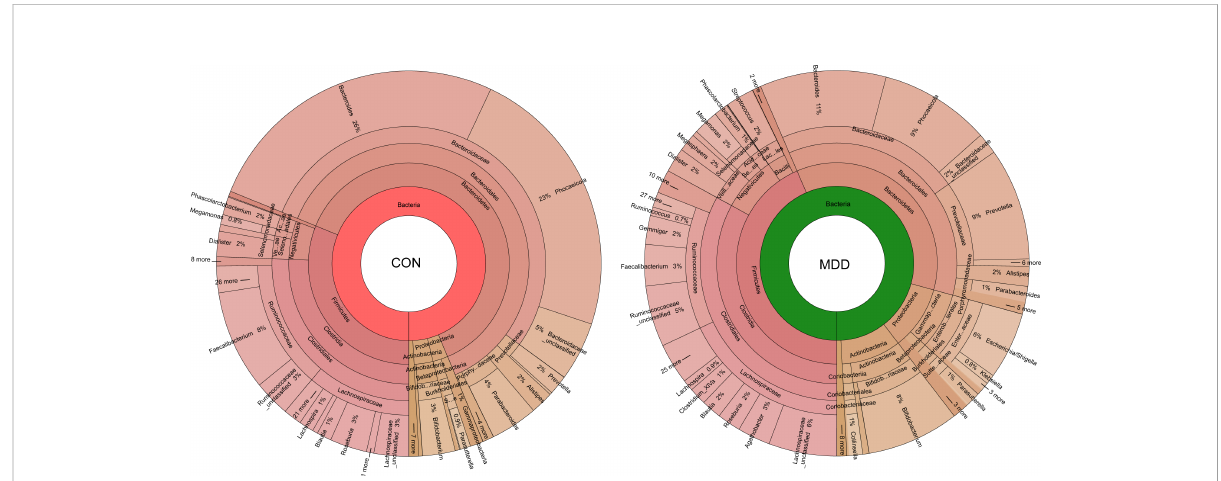
FIGURE 2 Krona charts showing the taxonomic identi fi cation and relative abundance of the most abundant bacterial OTUs recorded in childhood MDD patients and healthy controls. These taxa represent the internal core microbiota at the individual